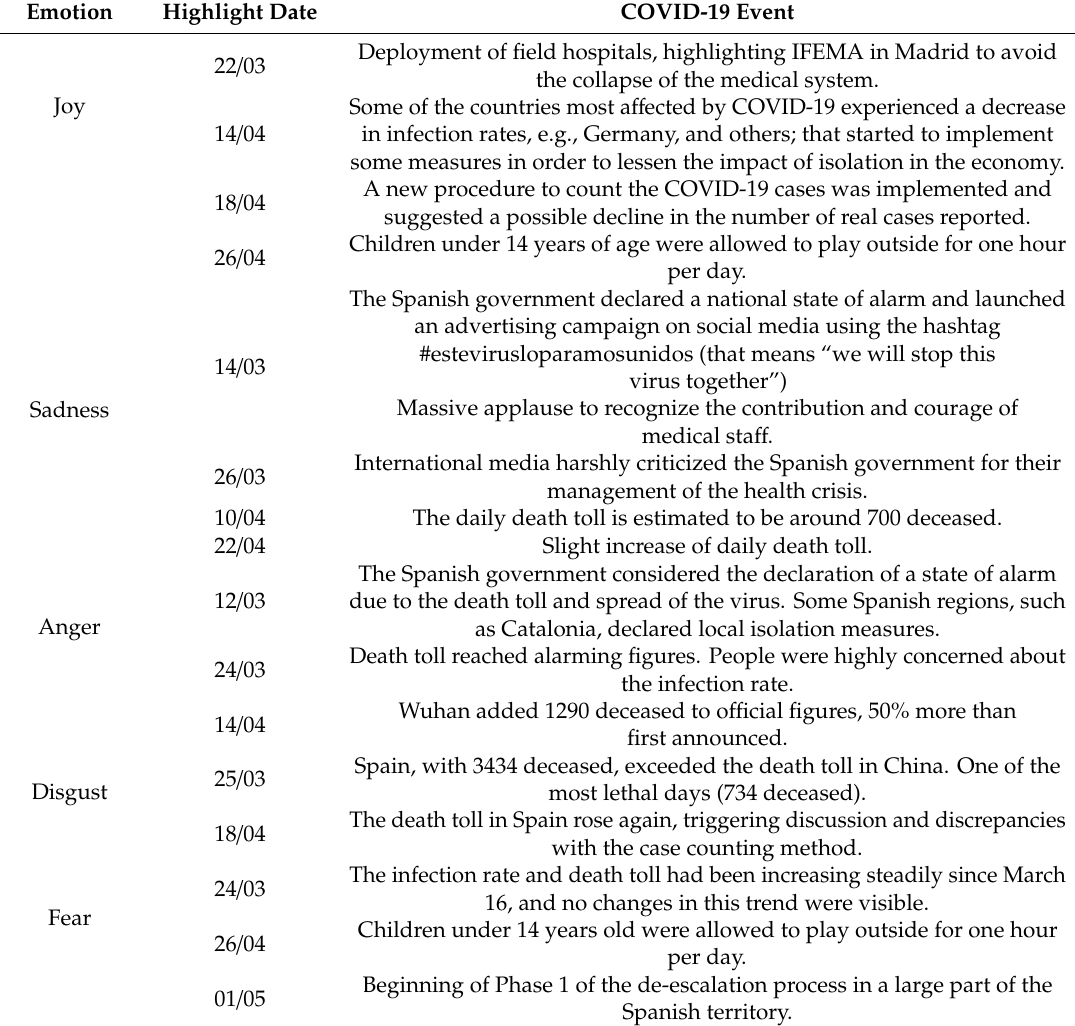
Table 1. Emotional response